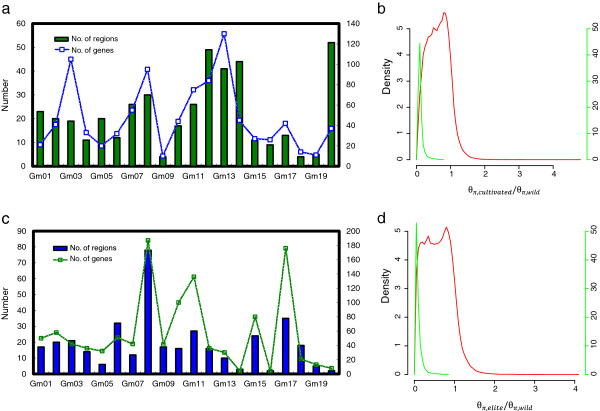
Detection of candidate genome region and genes underwent selection during domestication and genetic improvement. The distribution of domestication (a) and genetic improvement (c) regions and genes on the soybean chromosomes. Rectangular bar, number of regions; line, number of genes. Polymorphism distribution between cultivated (landrace plus elite) and wild populations (b), as well as between elite and wild groups (d) in candidate region (green line) versus the whole genome (red line).